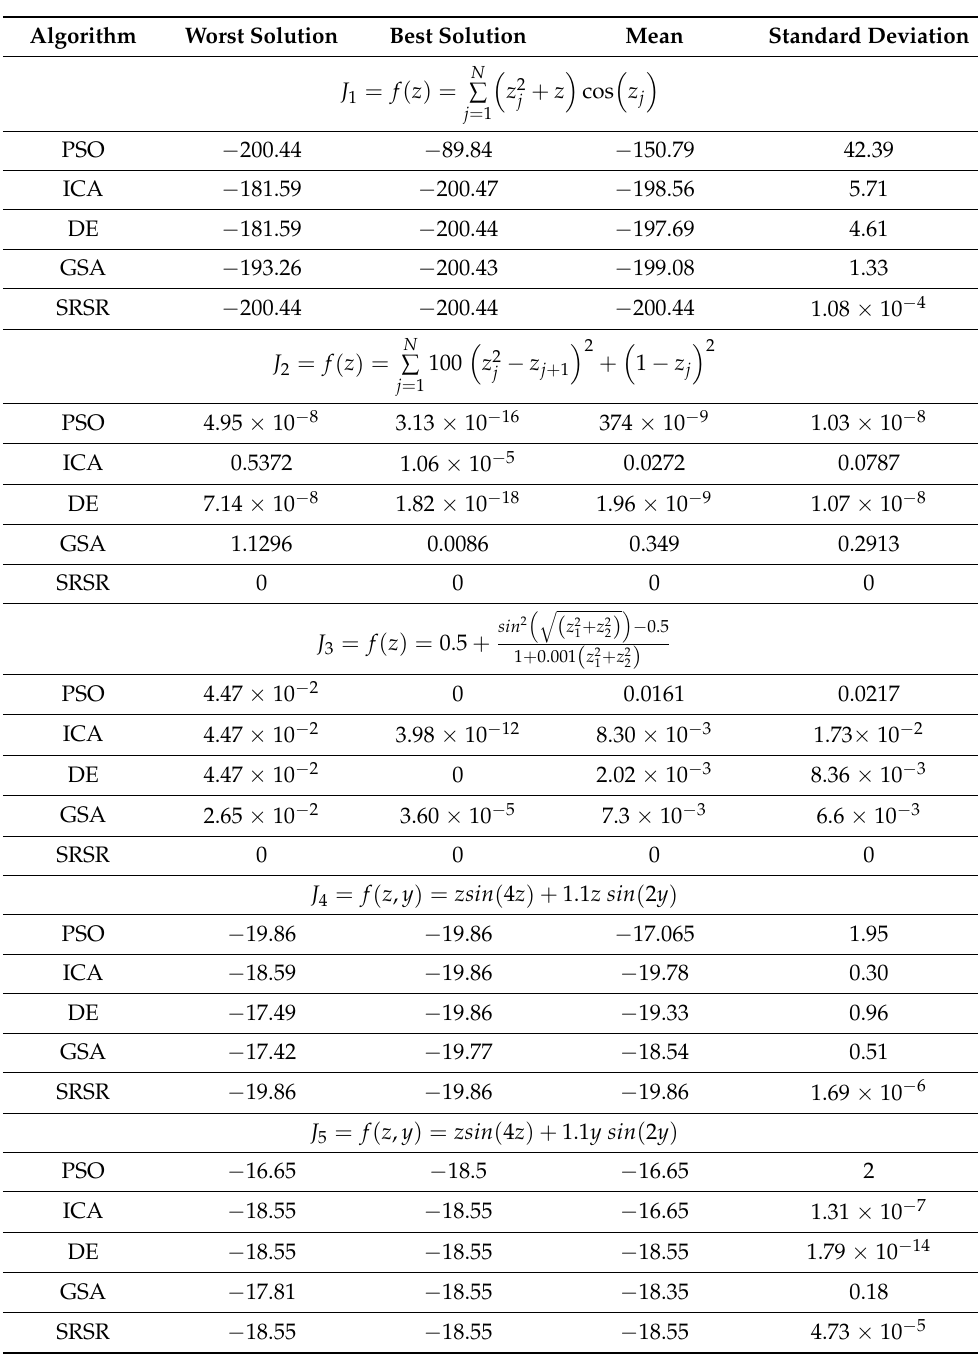
Table A1. Comparison solutions: Benchmark function (J); interval ( − 10, 10). Algorithm Worst Solution Best